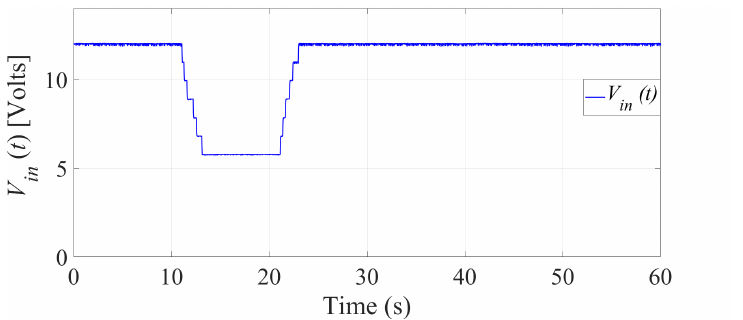
Figure 22. Input voltage V in ( t ) to test the closed-loop system implementing the proposed nonlinear PID